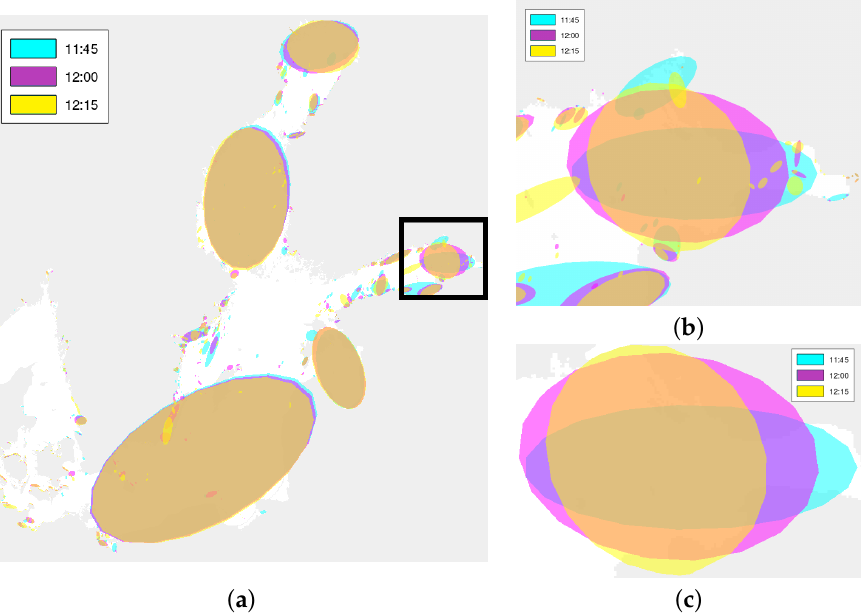
Figure 4. Time series moments: ( a ) masks 10/July/2019 11:45-12.15 UTC+02:00, ( b ) example of realized ellipses difference, and ( c ) example for separated cloud.